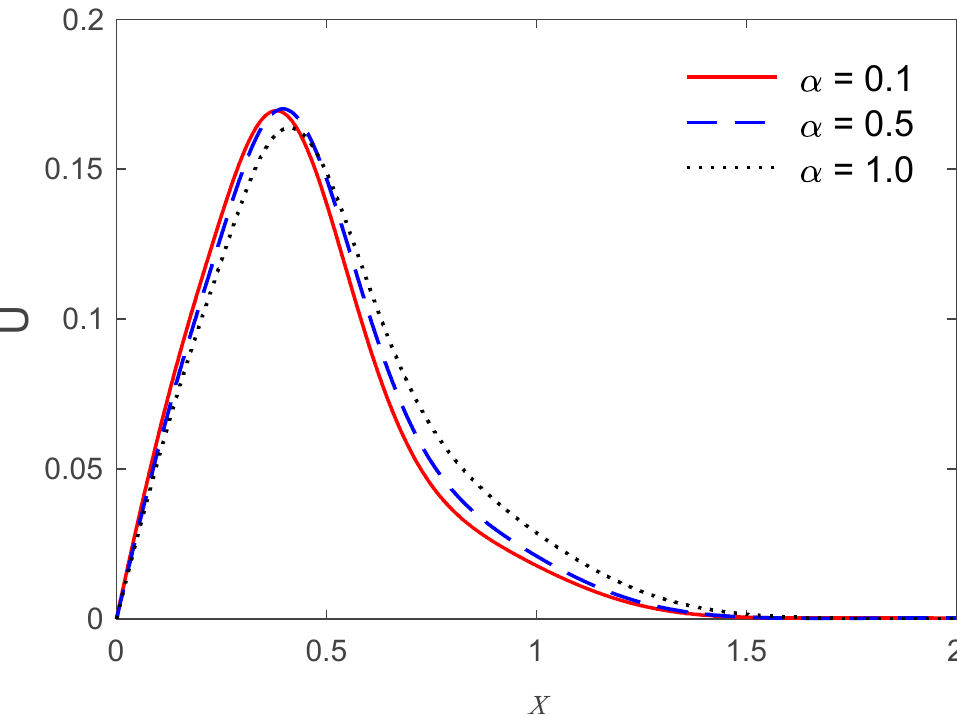
Figure 3. The displacement of fluid distributions 𝑈 via 𝑥 for three values of fractional parameter.